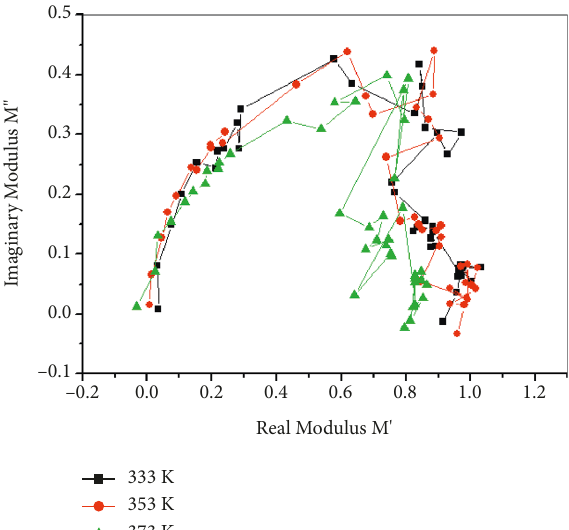
Figure 15: Phase angle vs log F.